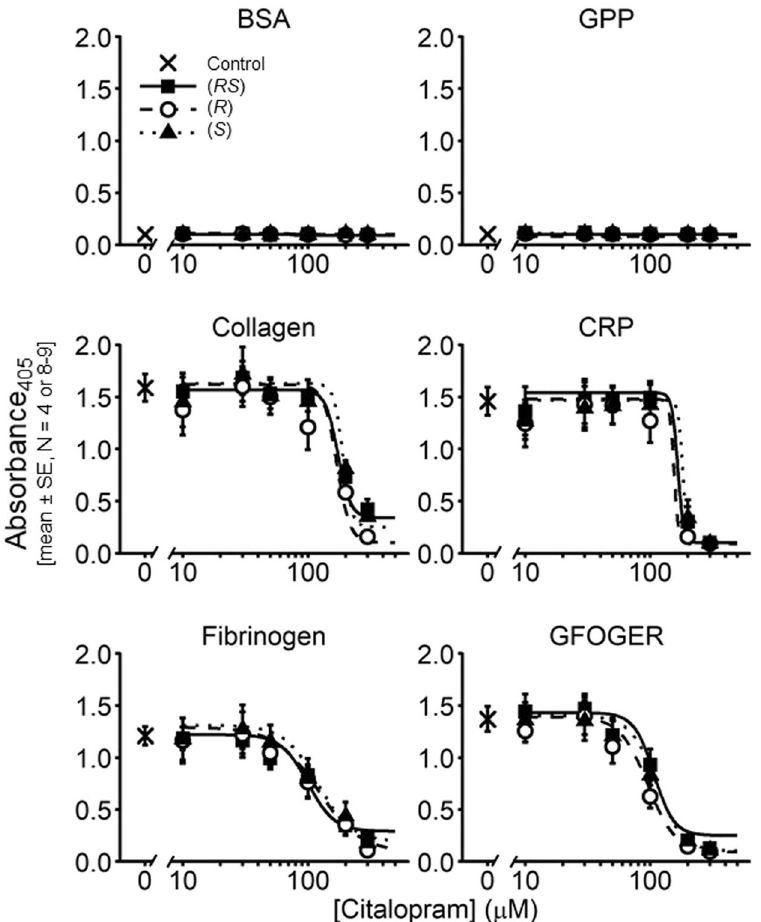
Figure 2. Inhibition by citalopram under static conditions of platelet adhesion to Horm collagen, CRP, fibrinogen and GFOGER. BSA and GPP were used as negative controls. Full concentration-inhibition curves were obtained for ( RS )-, ( R )- and ( S )-citalopram (0–300 µ M) for each ligand. 3-way ANOVA was performed with IBM SPSS v.23 (Effect 1 (fixed) = citalopram preparation {( RS ), ( R ), ( S )}; Effect 2 (fixed) = ligand {collagen, CRP, fibrinogen, GFOGER}; Effect 3 (random) = donor {N = 8–9 ( RS ) and N = 4 ( R ), ( S )}). The results indicated no difference in the pIC 50 of the three citalopram preparations ( P = 0.32, F = 1.18, df = 2, 44. H 0 : μ RS = μ R = μ S ; H 1 : μ RS ≠ μ R ≠ μ S